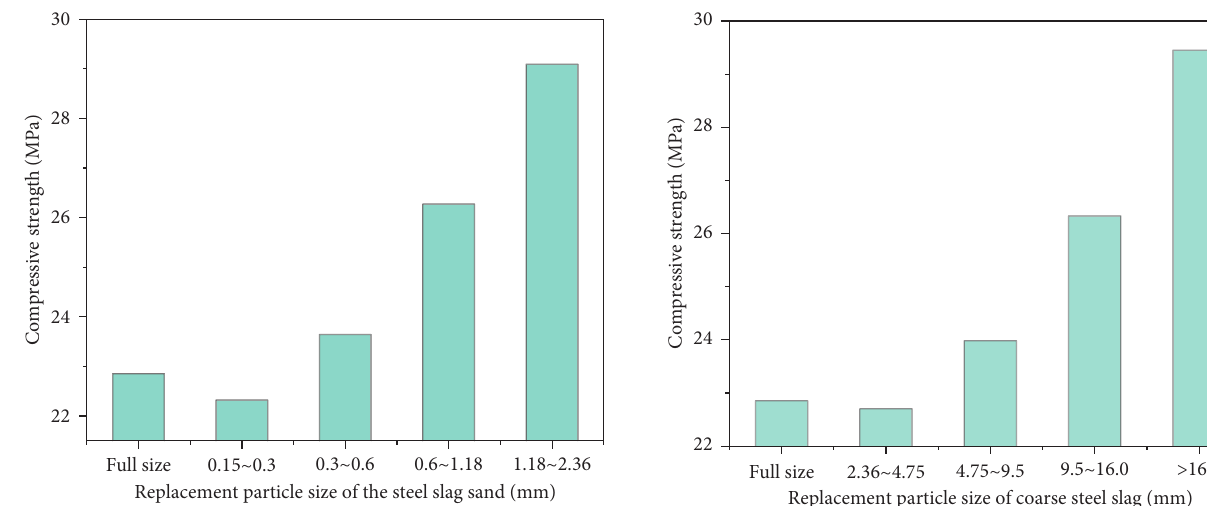
Figure 10: The impact of the replacement particle size of steel slag sand on the compressive strength of the FSSAC.